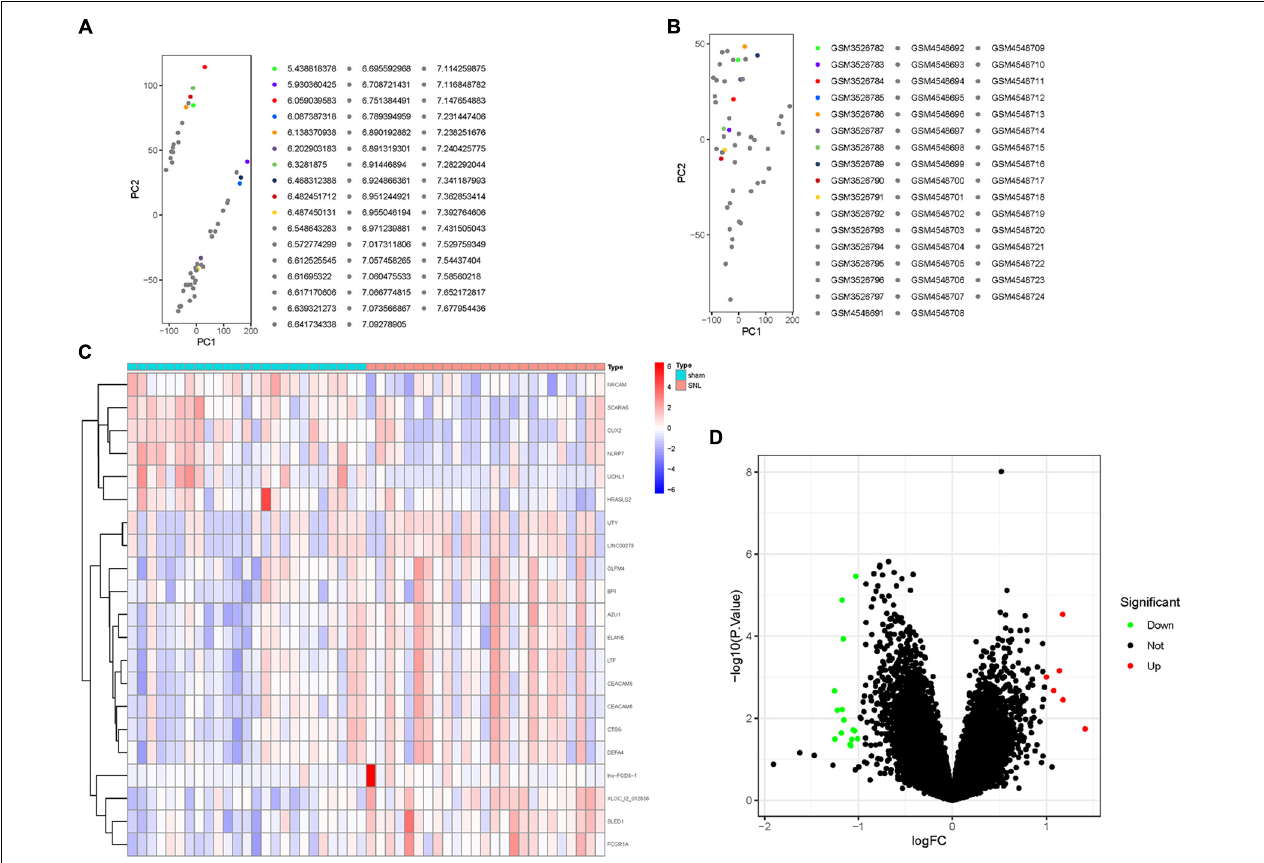
FIGURE 2 | The distribution of RNA in lumbar disc herniation (LDH) after merging the GSE124272 and the GSE150408 datasets. (A) In the two-dimensional PCA cluster plot of the merged dataset before normalization, with each point representing a sample. (B) In the two-dimensional PCA cluster plot of the merged dataset after normalization, with each point representing a sample. (C) The expression level of RNA in LDH. The higher the level of expression, the darker the color (red represents upregulated, green represents downregulated). The tree on the left showed the clustering results of significant RNA in different samples. The grid on the right indicated the groups (red represented normal group and blue represented LDH group). (D) Volcano map of differentially expressed genes (DEGs); red represents upregulated differentially expressed genes (DGEs), gray represents no significant DGEs, and green represents downregulated